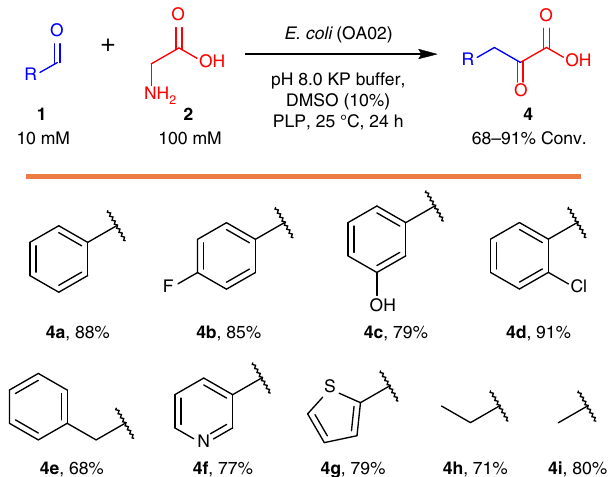
Fig. 4 Analytical biotransformation of glycine and aldehydes 1a – i to α -keto acids 4a – i with E. coli OA02. Reactions were performed in duplicate with resting cells E. coli (OA02) (10 g dcw l − 1 ) and 1a – i (10 mM) in KP buffer (50 mM, pH 8.0, 100 µ M PLP, and 10% DMSO) at 200 rpm and 25 °C for 24 h. The values are averages of two Table 1 Analytical biotransformation of glycine and aldehydes to α -hydroxy acids by cascade catalysis